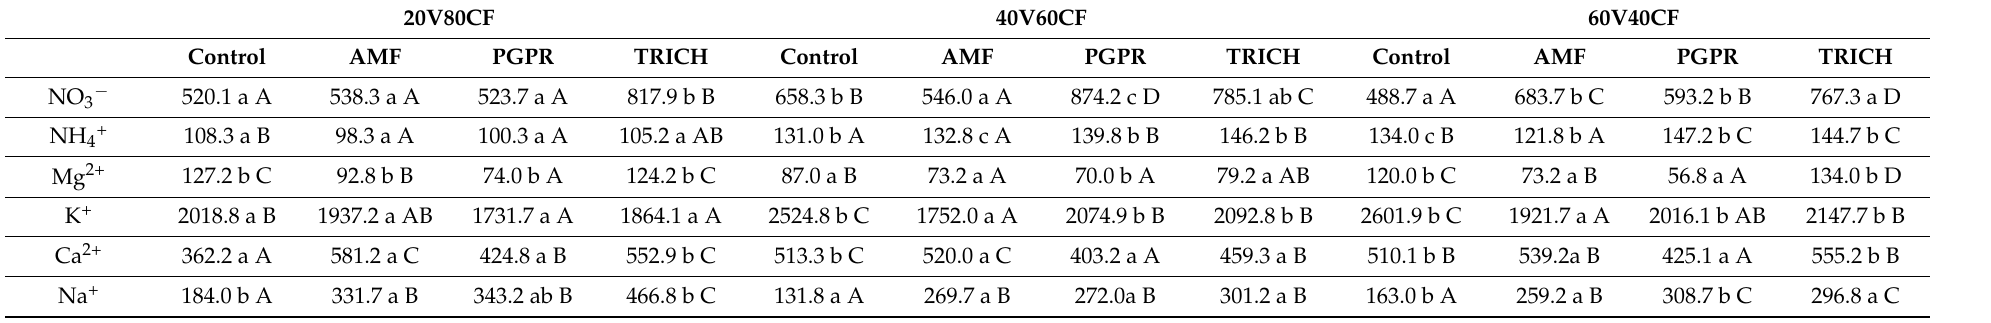
Table 6. Sap analysis (mg L − 1 ) of main cations and anions in the melon crop between substrate and PGPMs treatments.